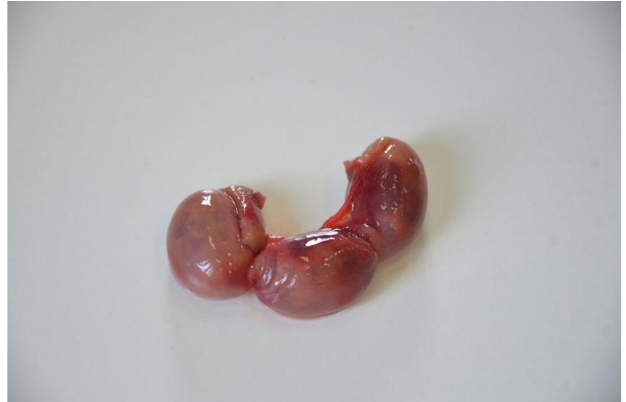
Figure 9. Uterus. Leiomyoma. Cells resemble smooth muscle, are relatively uniform and had no mitoses. H&E staining, bar = 100 µ m.